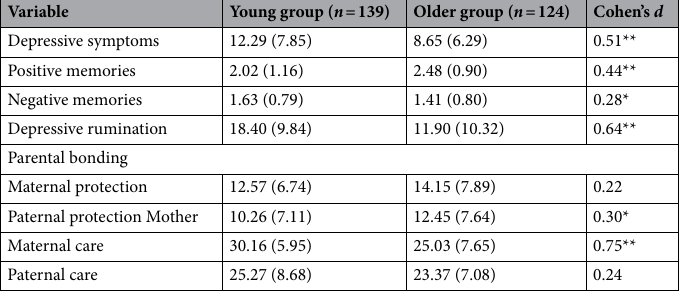
Table 1. Means and (standard deviations) for the main variables in the study by age group. **p < .001 ; *p < .05.